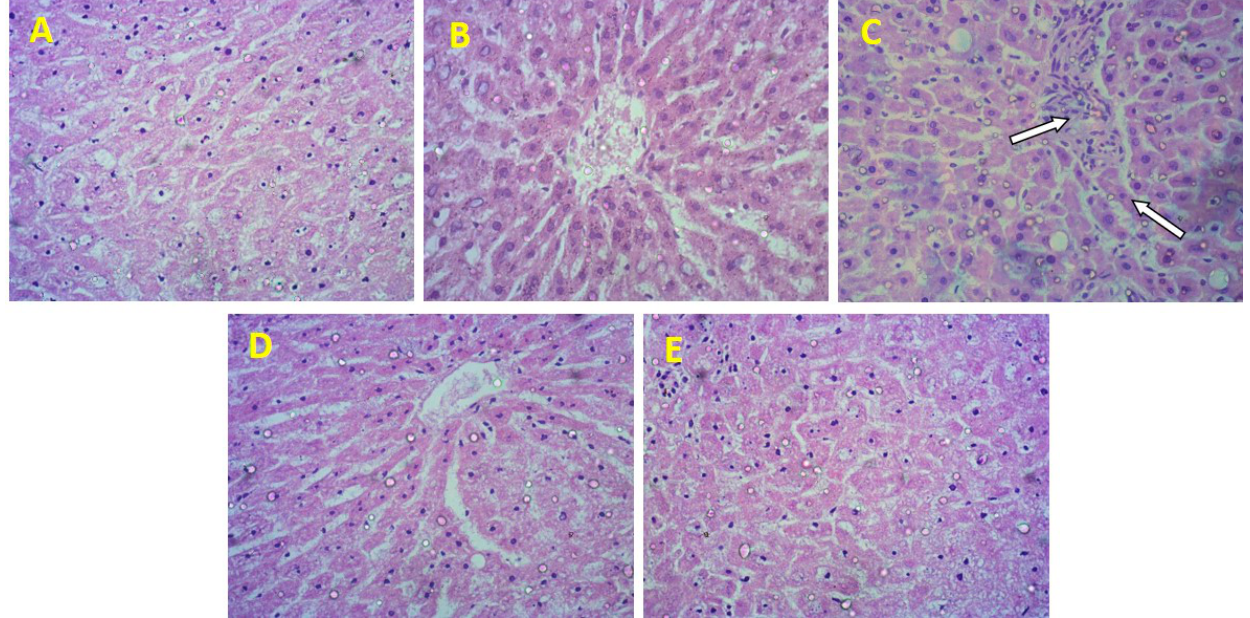
Figure 10. Effects of B. lacera leaf extract and its liposomal preparation on CCl 4 -induced hepatic inflammation. ( A ) Control (Oil), ( B ) Control (Blank), ( C ) CCl 4 , ( D ) CC 4 + suspension of B. lacera leaf extract, ( E ) CCl 4 + liposomal nano formulation of B. lacera leaf extract. n = 6 per group; magnification = 40×.